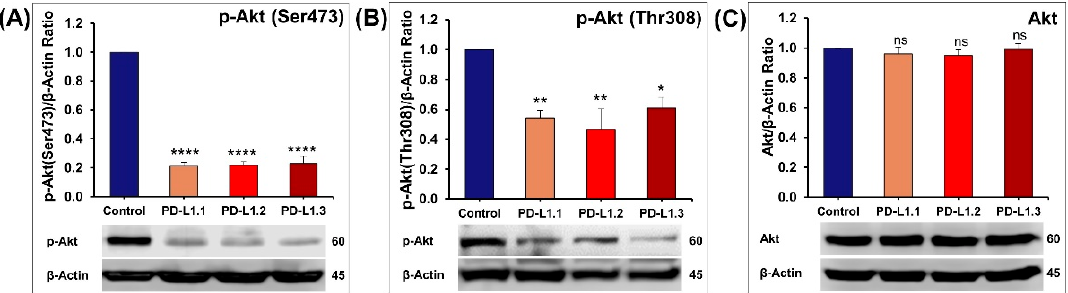
Figure 7. Quantification of the western blot showing the impact of PD-L1 knockout on the expression of p-Akt (Ser473) ( A ), p-Akt (Thr308) ( B ), and total Akt ( C ). Columns represent mean of at least three independent experiments; bars represent S.E.M. * p < 0.05. ** p < 0.01. **** p < 0.0001. ns—non-significant.